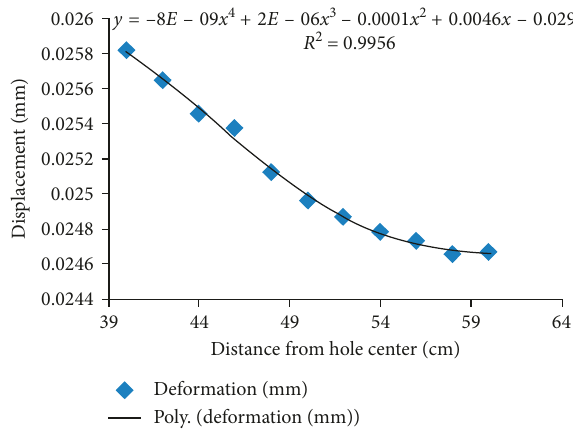
Figure 9: Displacement versus distance from the hole center.